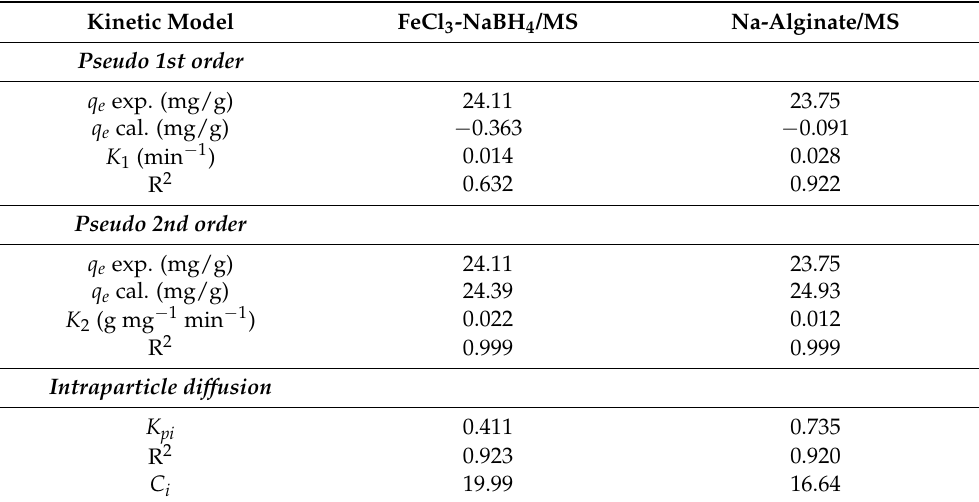
Table 1. Kinetic constant parameters for the adsorption of 2,4,6-TCP onto FeCl 3 -NaBH 4 /MS and Na-Alginate/MS